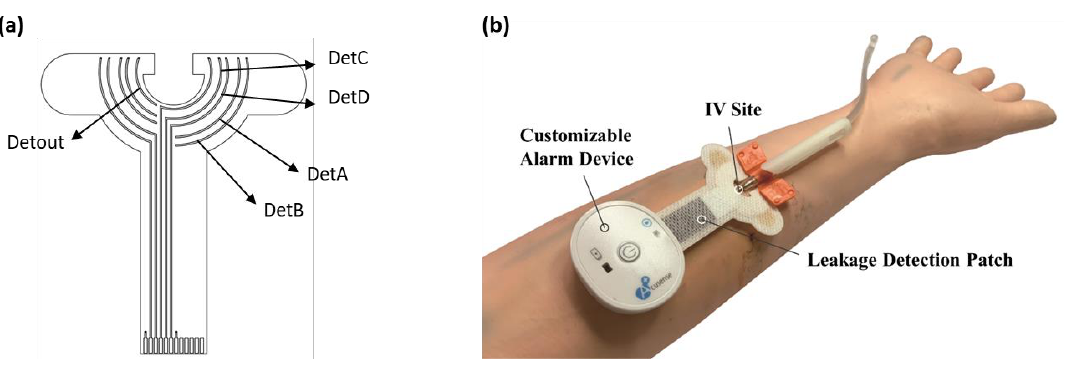
Figure 1. Sensor patch layout and the in vitro setup for testing the device. ( a ) Sensor patch layout. The cross-ring design architecture from the inside out was designed to detect leakage from all directions. ( b ) The performance of the leakage-detection patch was tested on a prosthetic arm with other parts of the detection device.